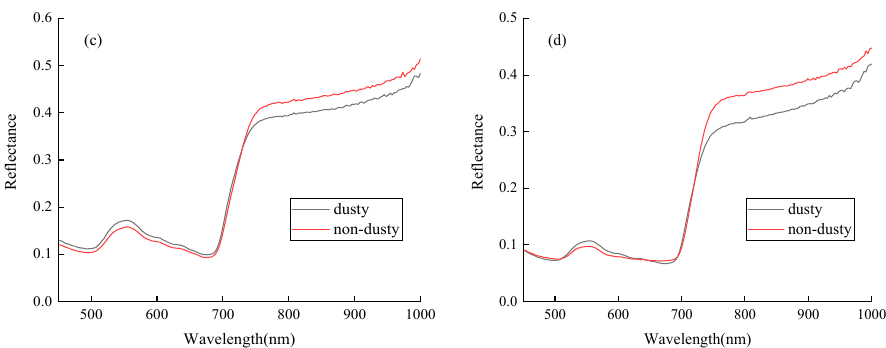
Figure 3. Reflectance of dusty and non-dusty leaves. (a) Leymus chinensis, (b) Cleistogenes squarrosa, (c) Potentilla acaulis, (d) Scutellaria scordifolia.